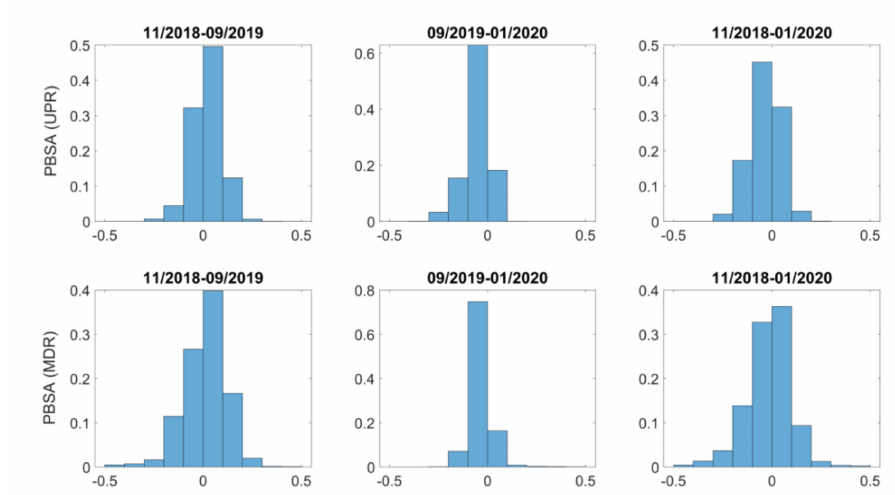
Figure 9. Normalized histograms of the elevation di ff erences shown in Figure 8 for the Upper and Middle PBSA, comparing the 2018, 2019, and 2020 3DPCs. Table 2. Changes in unit volume (dm 3 m − 2 ) and total mean volume per budget cell (dm 3 ) obtained